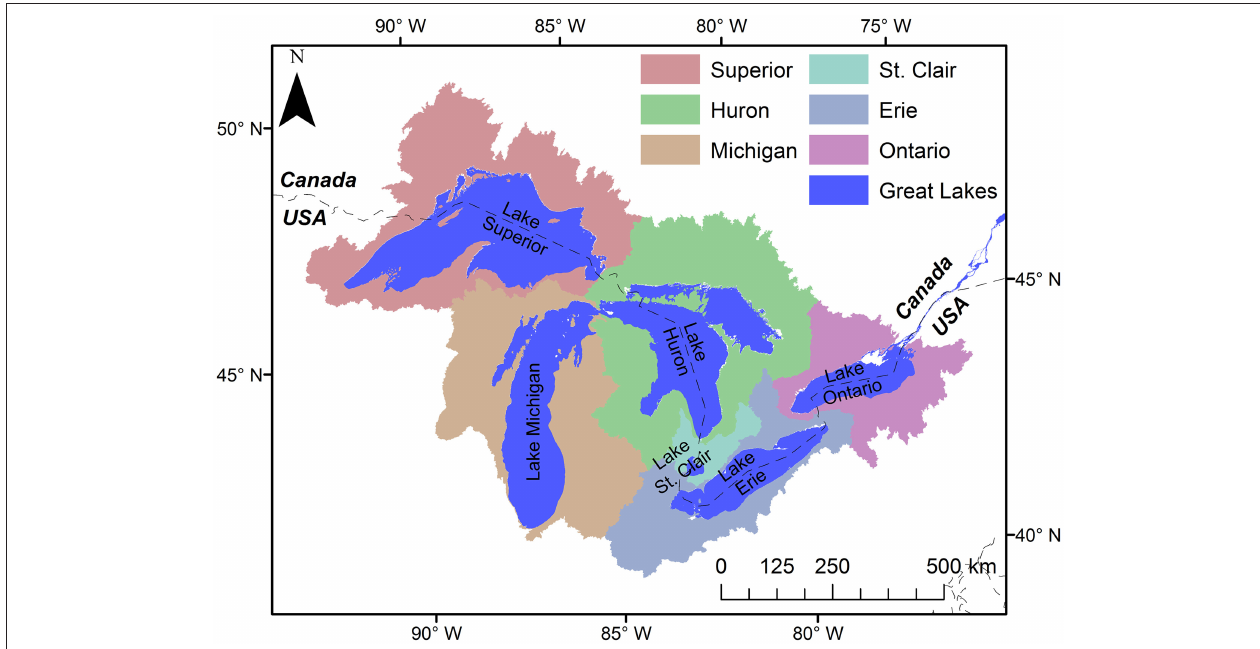
FIGURE 1 | The Laurentian Great Lakes with their respective drainage